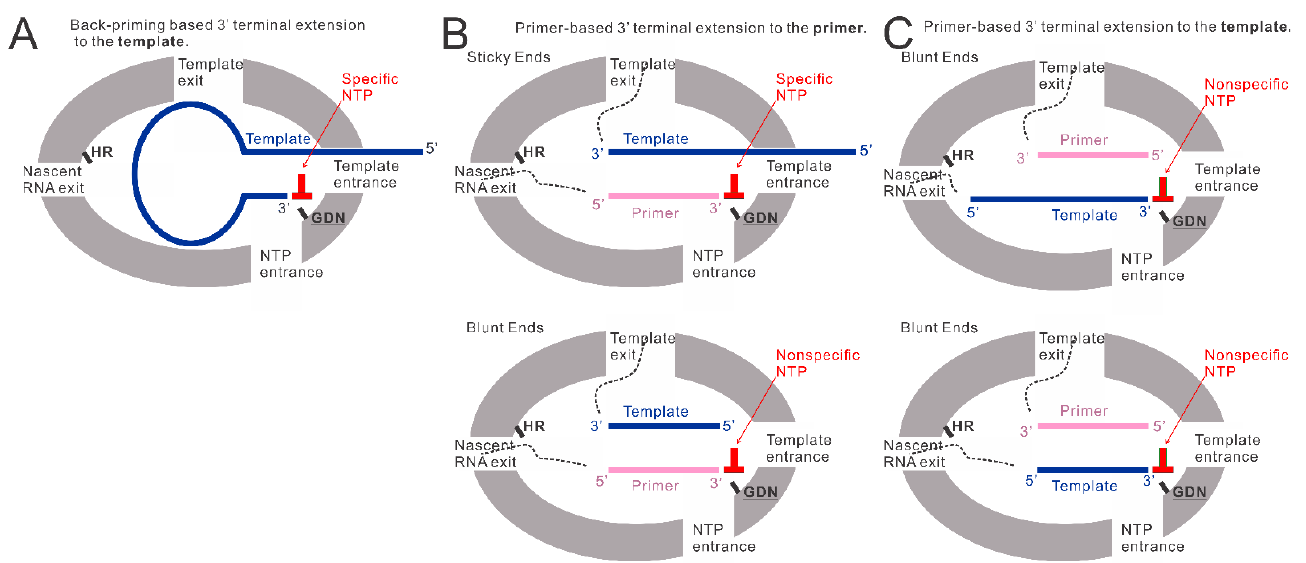
Figure 6. The models of back-priming-based and primer-based 3 (cid:48) terminal extension to the template and primer. ( A ) The model of back-priming-based 3 (cid:48) terminal extension to the template by RSV polymerase. It may incorporate a wobble base pair with low activity only when only a high concentration of nonspecific NTP was added to the reaction mixture. ( B ) The model of primer-based 3 (cid:48) terminal extension to the primers. The incoming NTP will be specifically added to the sticky end when the template is longer than the primer. When the supplemented NTP is nonspecific, a wobble base pair may be introduced into the product by RSV polymerase with low activity. While the template is the same length as the primer, the RSV polymerase may add a nonspecific NTP to the blunt end of the double-strand RNA at the 3 (cid:48) end of the primer. ( C ) The model of primer-based 3 (cid:48) terminal extension to the templates. The double-strand RNA (template paired with the primer) may enter the active pocket to access the GDN catalyze motif in RdRp domain, allowing a nonspecific NTP addition to the 3 (cid:48) blunt end of the template. GDN are the catalytic residues in the RdRp domain responsible for RNA polymerization. HR are the catalytic residues in the Cap domain responsible for mRNA